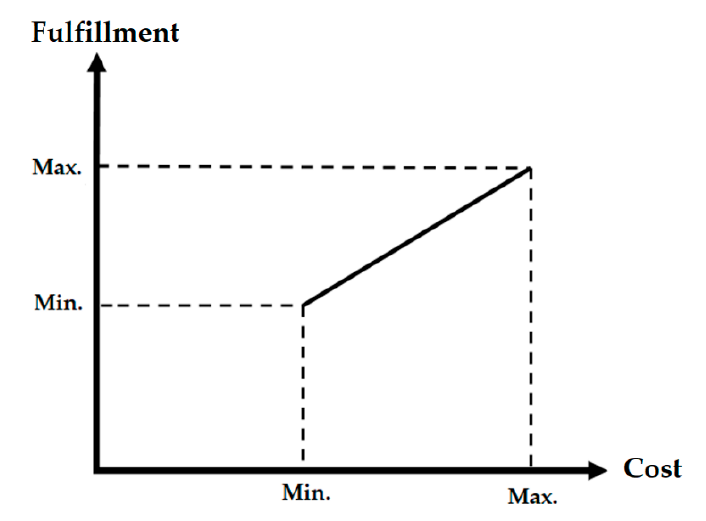
Figure 3. Cost function diagram [10].